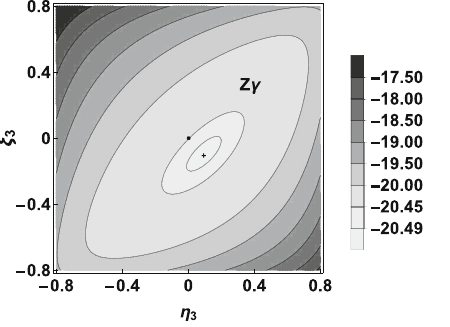
Fig. 6 Same as Fig. 5 but for the Z γ process. The plus mark at P Z γ = ( + 0 . 09 , − 0 . 10 ) is the lowest likelihood point and hence the best choice of beam polarizations for Z γ process